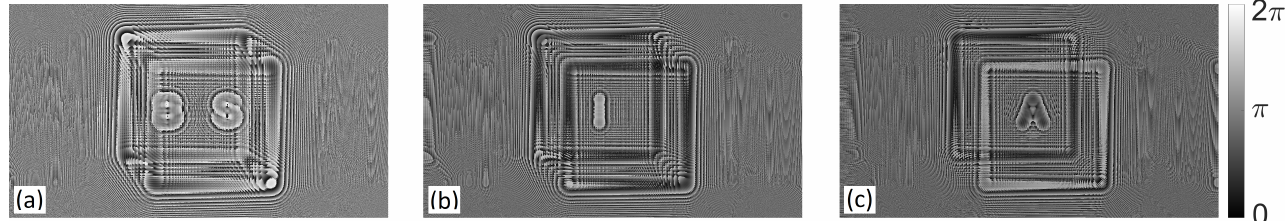
Figure 3. Diffraction patterns of a wire frame cube and the letters BIAS, inscribed into one of the two SLMs for temporal multiplexing of three colors red, 633 nm ( a ), green, 532 nm ( b ), and blue, 488 nm ( c ). Additionally to the diffraction pattern itself being wavelength-dependent due to the propagation in Equation (5), the refractive properties of the SLM are wavelength-dependent, resulting in scaled phase values inscribed into the SLM for varying